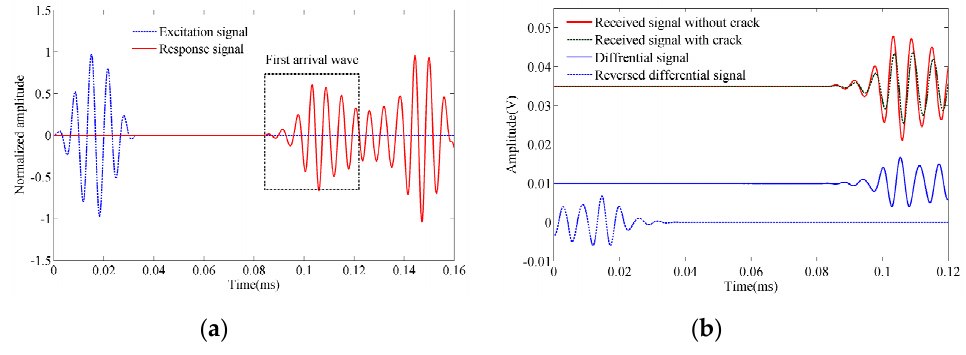
Figure 10. Extraction of the damage signal: ( a ) Excitation signal and response signal; ( b ) received signal of the beam with/without crack, their differential and reversed signal.